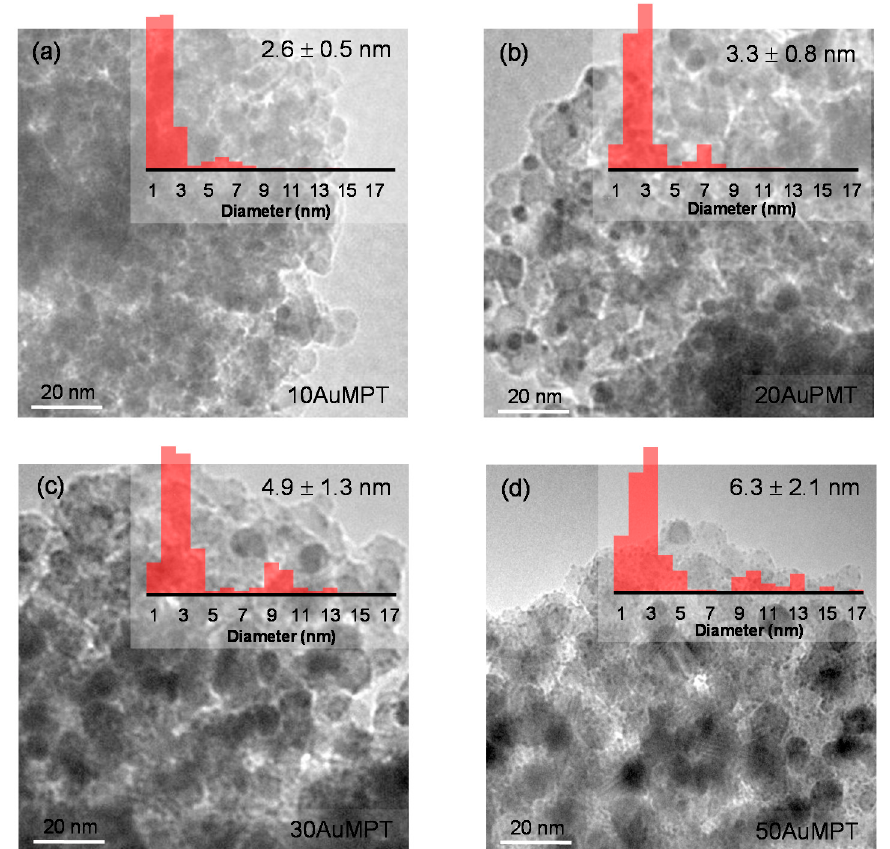
Figure 2. TEM images of various AuNP-loaded MPT (mesoporous TiO 2 ) particles prepared via deposition precipitation as a function of the applied amount of gold salts: ( a ) 10 wt%; ( b ) 20 wt%; ( c ) 30 wt%; ( d ) 50 wt%. Table 1. Preparation of composite particles as a function of the amount of gold